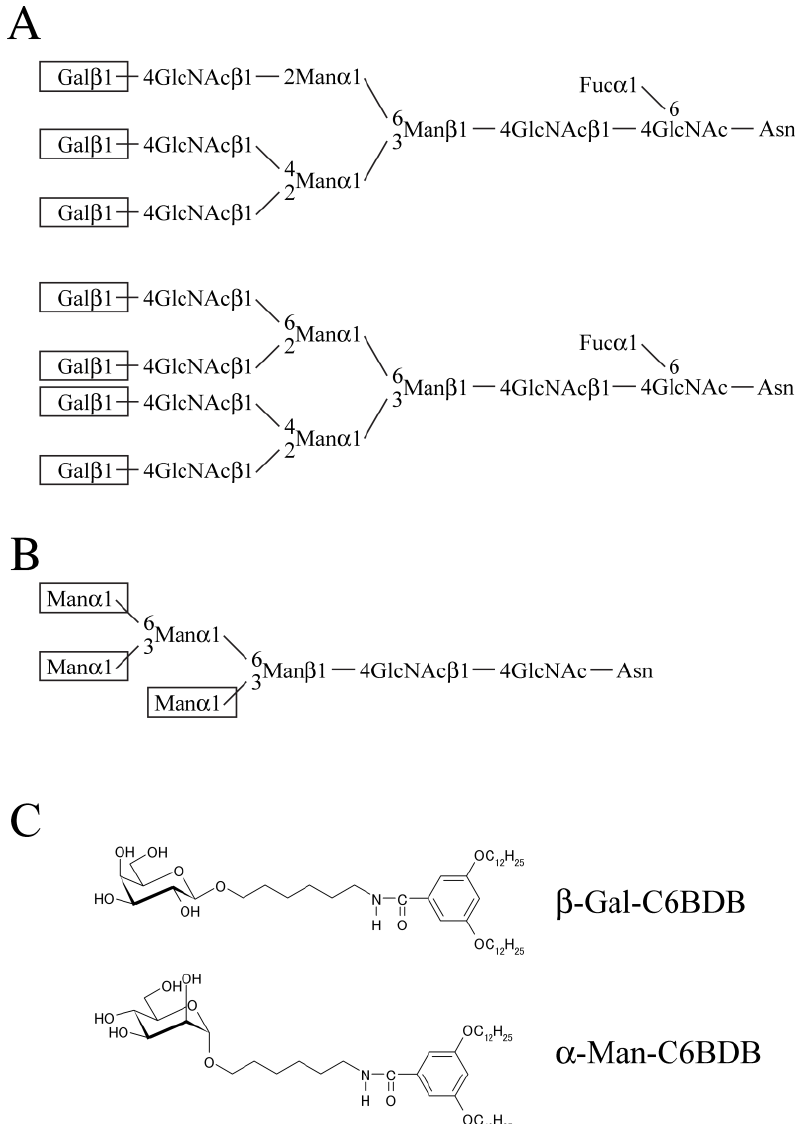
Figure 1. Sperm ligand carbohydrate chains of porcine and bovine zonae pellucidae and chemical structures of glycolipid analogs. The nonreducing terminal β-Gal residues (boxed) of the complex-type chains shown in (A) are sperm-binding sites in the porcine-zona pellucida [18] . The nonreducing terminal α-Man residues (boxed) of the high-mannose-type chain shown in (B) are sperm-binding sites in the bovine-zona pellucida [17] . (C) Structures of glycolipid analogs. In addition to these two analogs, β-GalNAc-C6BDB, β-Glc-C6BDB, β-GlcNAc-C6BDB, and α-NeuAc-C6BDB were used in the present study. Nonreducing terminal β-Gal and β-GalNAc have C-3 equatorial and C-4 axial OH groups, while nonreducing terminal α-Man, β-Glc, and β-GlcNAc have C-3 equatorial and C-4 equatorial OH